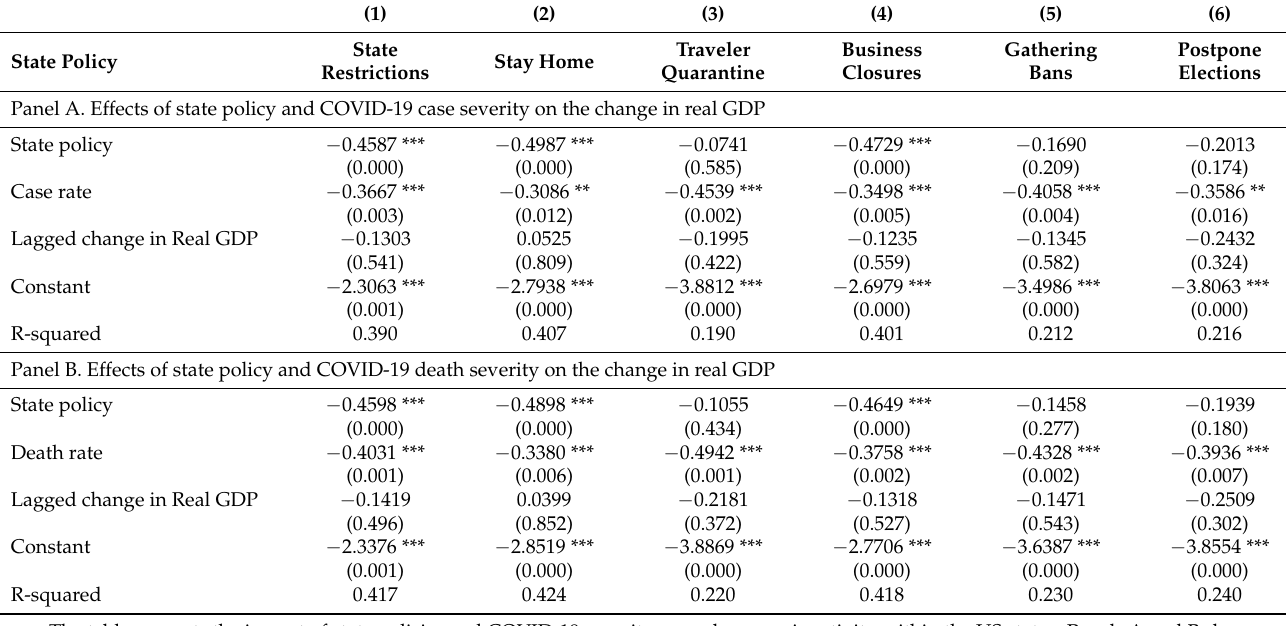
Table 5. Effects of state policies and COVID-19 severity on local economic